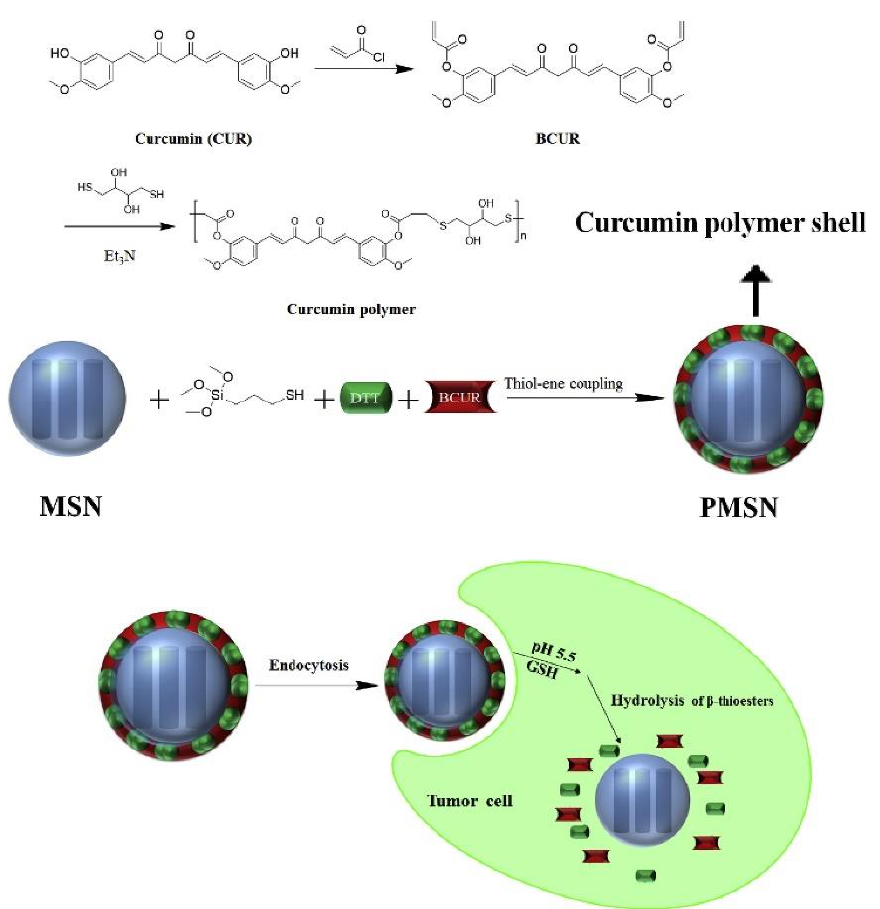
Figure 17. Illustration for the preparation of curcumin polymer, PMSN and intracellular microenvi- ronment triggered release. Reproduced with permission from ref. [163]. Copyright 2018 Elsevier Inc.